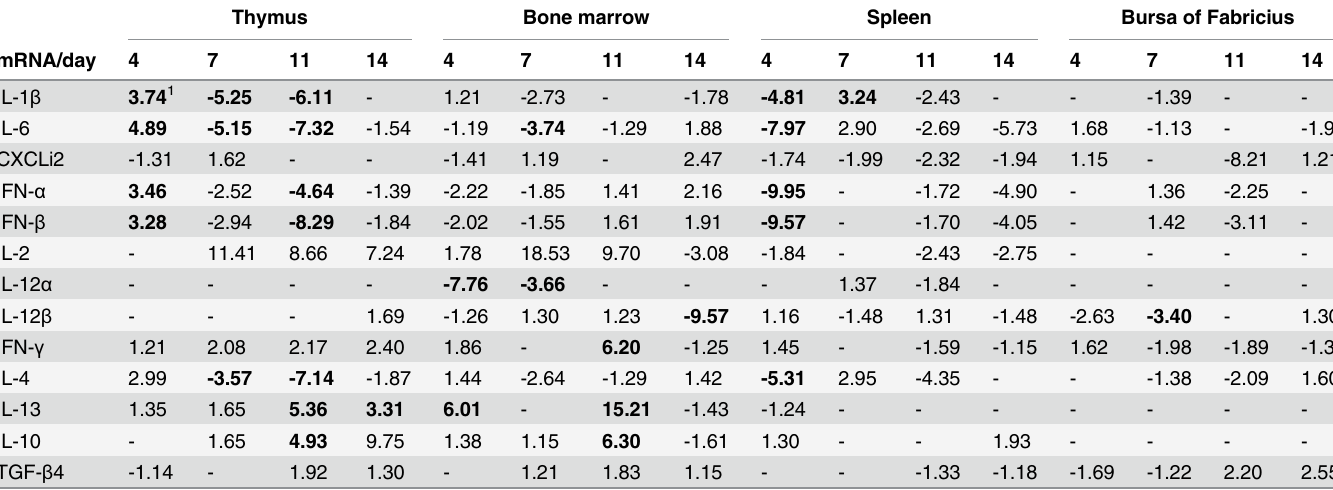
1 Mean fold difference between infected and mock-infected birds at each time-point (n = 5 (6 for d 14)); P < 0.05, positive values are up-regulated in infected birds and negative values are down-regulated in infected birds. — : no signi fi cant difference between groups or mRNA not expressed in one or both groups. Changes greater than three-fold are highlighted in